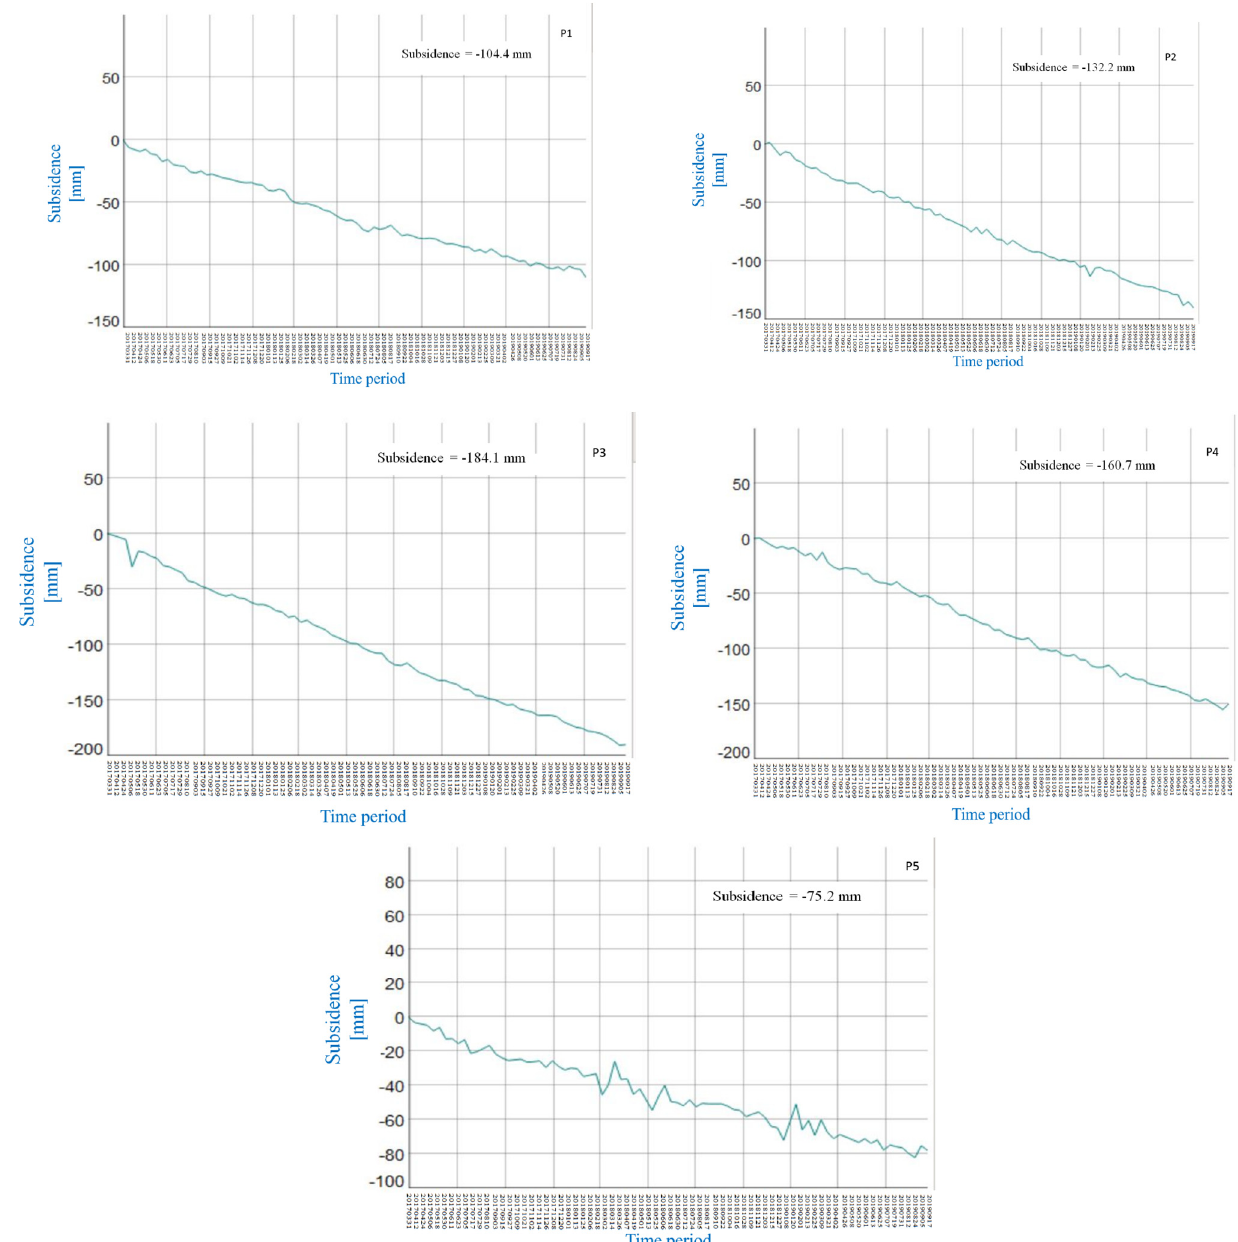
Figure 10. Subsidence along PS points (P1, P2, P3, P4, and P5) in descending track (x-axis is time 2017–2019. y-axis represents